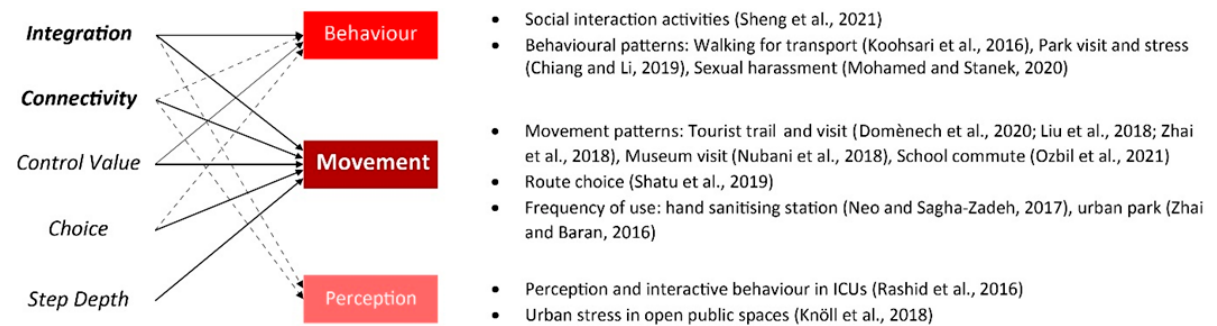
Figure 4. A collective model of the predictive relationships between syntactic and experiential var- iables [21,30,32,35,36,39,43,44,46,47,49,50,51,53]. variables